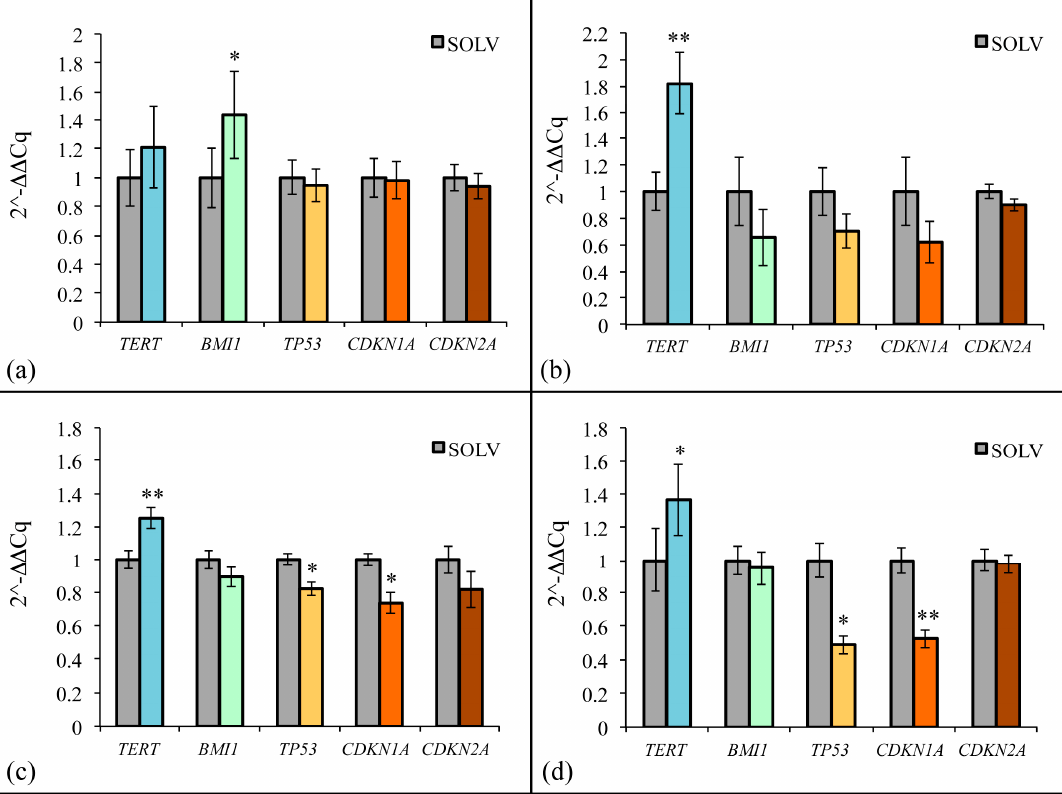
subjects. Statistical significance was evaluated by using the CFX Manager Software version 3.1